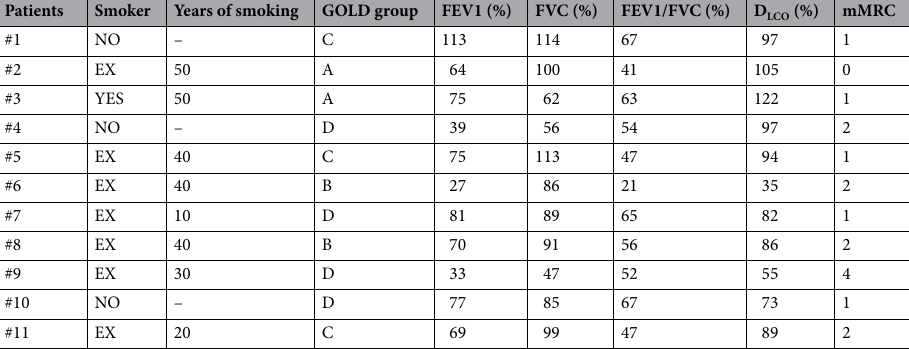
Table 2. Clinical data for the patients with COPD enrolled in this study. GOLD: Global Initiative for Chronic Obstructive Lung Disease; FEV1: forced expiratory volume in one second; FVC: forced vital capacity; FEV1/ FVC: ratio between two terms; D LCO: diffusing capacity for carbon monoxide; mMRC: modified Medical Research Council Dyspnea scale.